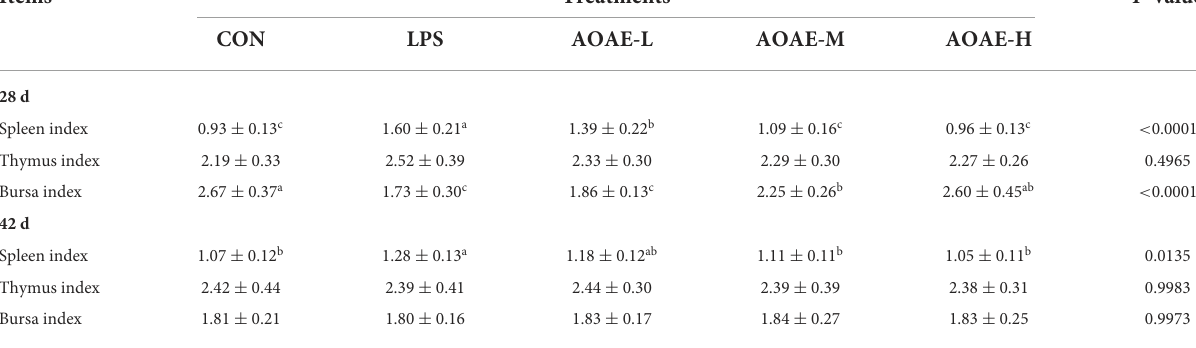
TABLE 4 Effect of AOAE on relative weight of immune organs in broilers challenged with